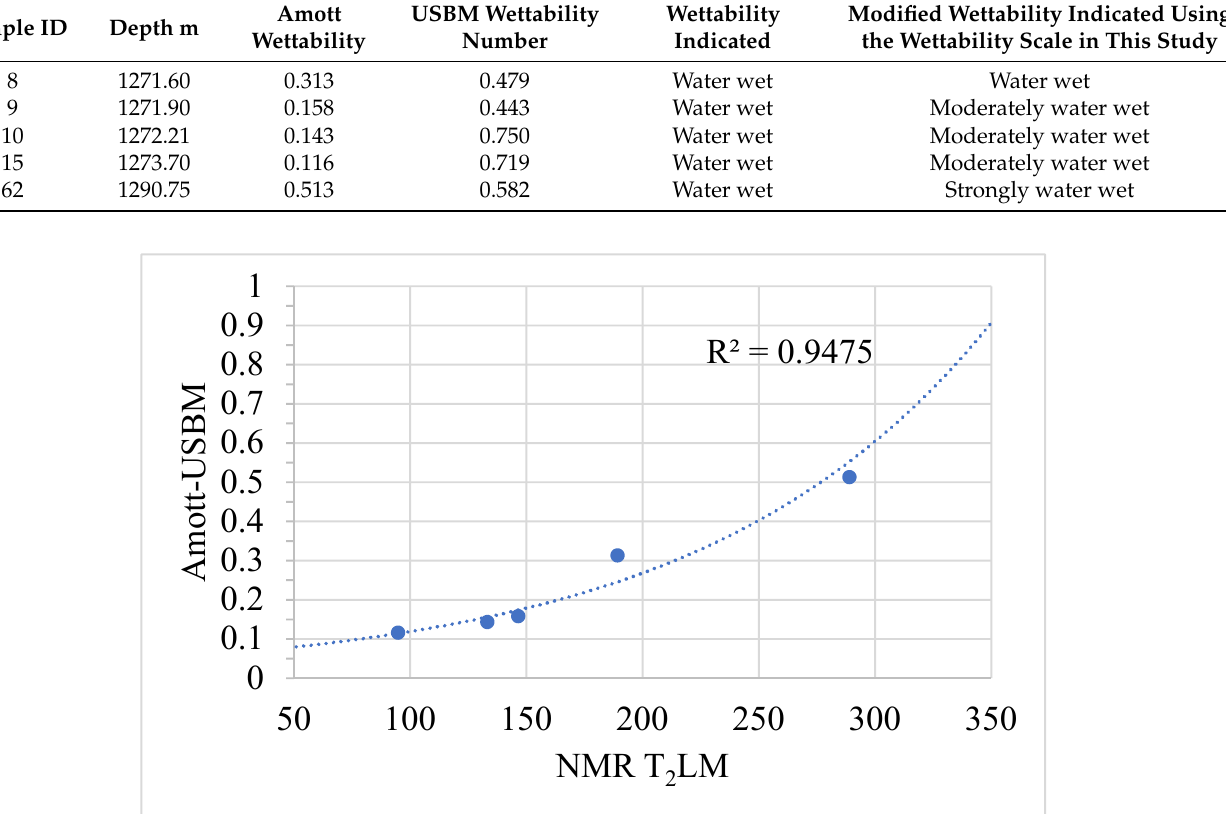
Figure 6. Application of Amott-USBM—NMR T 2 LM cross plot to establish an exponential relationship between core and log wettability data.